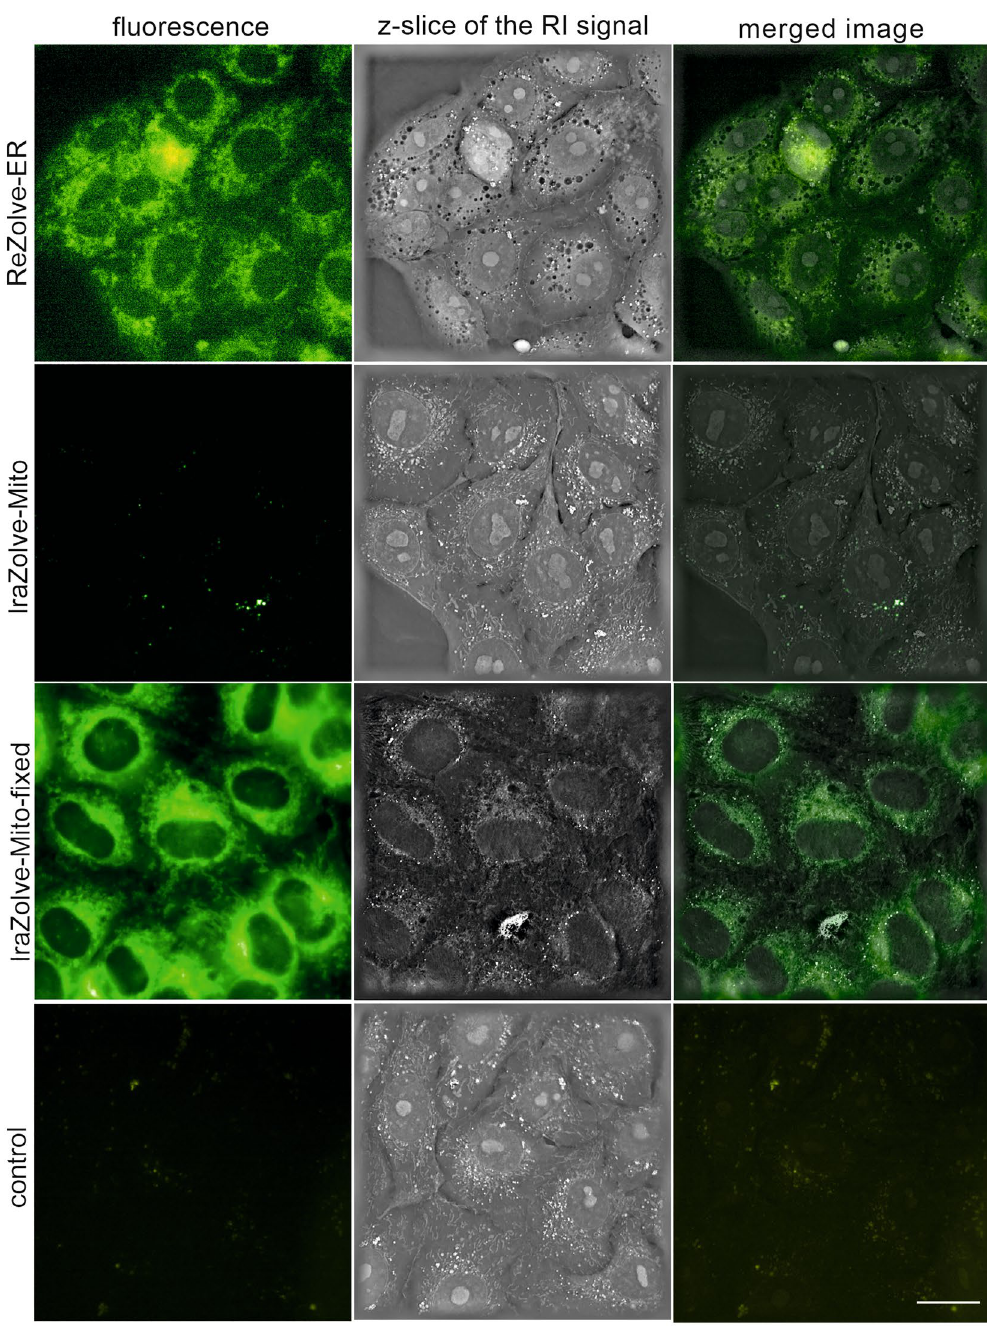
Figure 1. REZOLVE-ER and IRAZOLVE-MITO probes were used for imaging of endoplasmic reticulum and mitochondria of Vero cells, respectively. Holographic microscope 3D Cell Explorer (Nanolive). Bar 20 µm. RI (the refractive